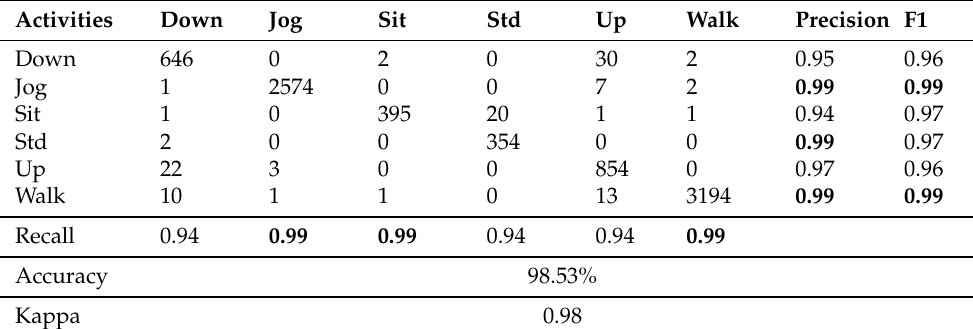
Table 5. Classification of the confusion matrix on the WISDM using the proposed model, CNN- BiLSTM, as a feature extractor and support vector machine (SVM) as a